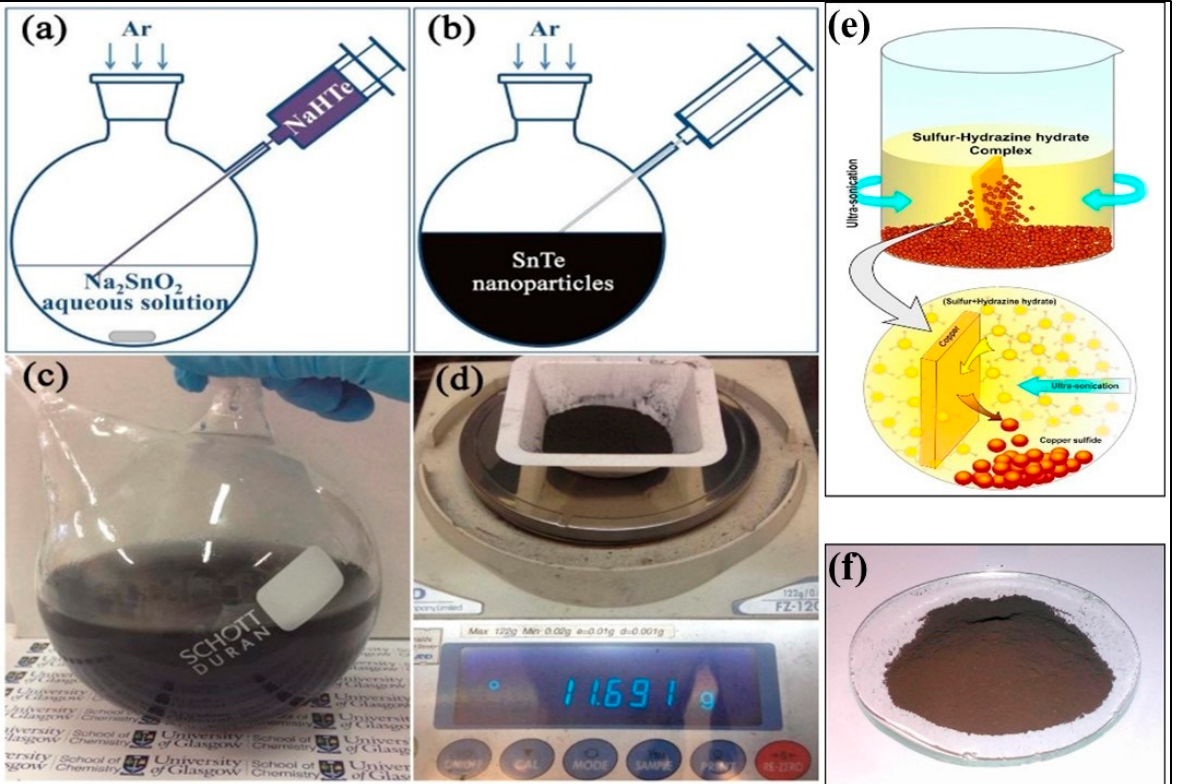
Figure 4. Solution synthesis of tin telluride (SnTe) nanoparticles, ( a ) Na 2 SnO 2 aqueous solution is injected with NaHTe solution, ( b ) Formation of tin telluride (SnTe) nanoparticles, ( c ) Photograph showing the solution after a scale-up synthesis, and ( d ) Typical yield of tin telluride (SnTe) nanoparticles prepared in a one-pot synthesis. Reproduced with permission from [62]. Copyright MDPI, 2017, ( e ) Bulk synthesis of copper sulfide by the ultrasonic experimental setup. ( f ) Photograph of prepared Copper sulfide using 1 M sulfur solution. Reproduced with permission from [63]. Copyright Elsevier, 2017.